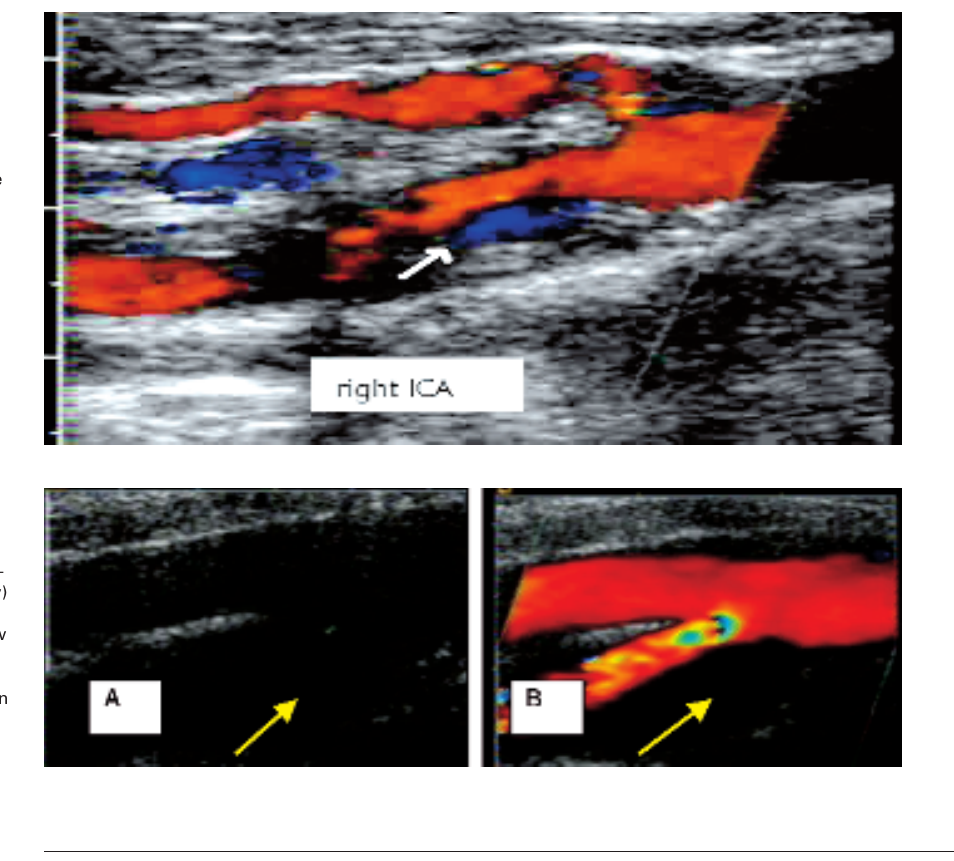
Figure 2 Ulcerated plaque of the internal carotid artery in a 64-year- old symptomatic patient. Notice the reversed flow on the surface of the plaque (white arrow) (from our ultrasound unit).